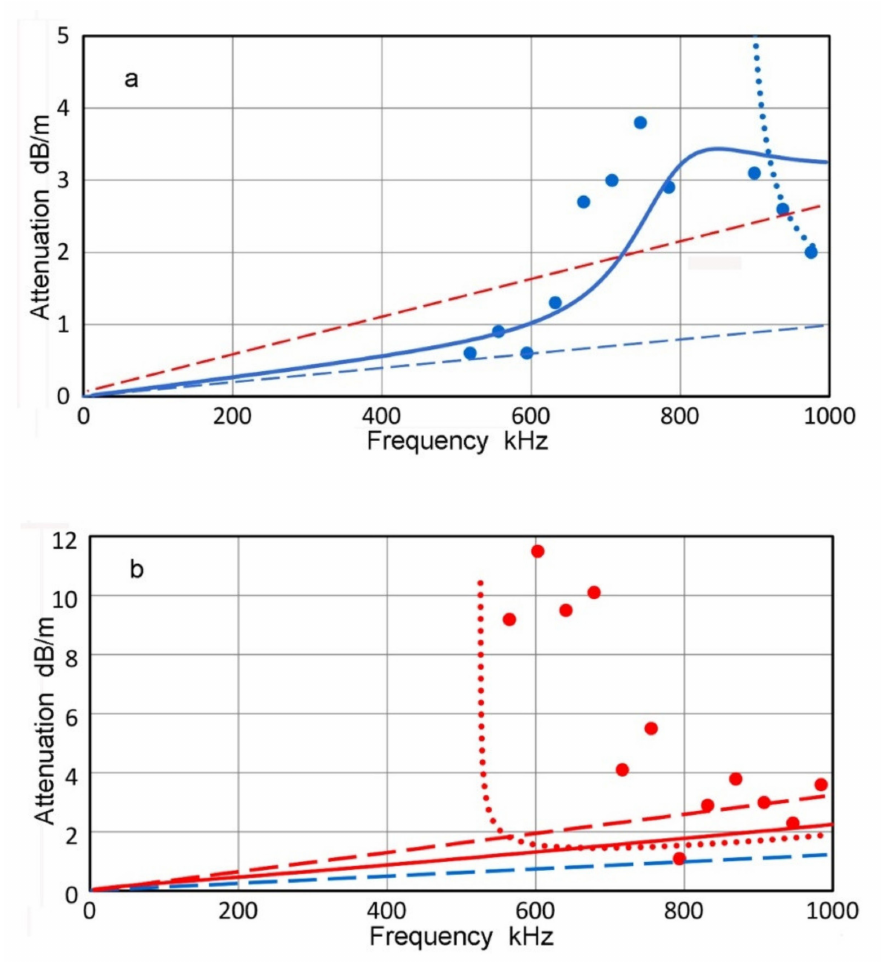
Figure 11. ( a ) α –S o values for 410SS sheet of 3.2-mm thickness plotted in blue dots with Olympus V101 as Tx and KRN-BB-PC as Rx. Calculated α –S o (solid blue curve), α –S 1 (blue dotted), α L and α α –A o values for 410SS sheet of 3.2-mm thickness T (blue and red dashed lines) are also plotted. ( b ) plotted in red dot symbols, using short-pulse excited NDT C16 Tx at 60 ◦ incident angle and KRN-BB- PC Rx. Calculated α –A o (solid red curve), α –A 1 (red dotted), α L and α T (blue and red dashed lines) are also